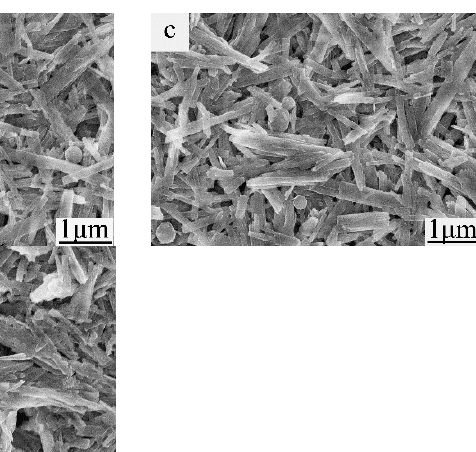
Batteries 2019 , 5 , x FOR PEER REVIEW 4 of 8